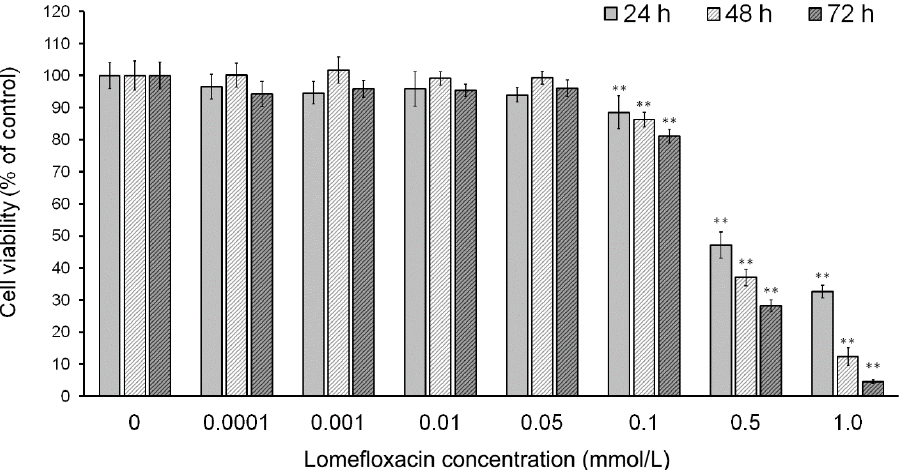
Figure 1. The effect of lomefloxacin on the viability of COLO829 melanoma cells. The cells were treated with various lomefloxacin concentrations (0.0001–1.0 mmol/L) for 24, 48, and 72 h and examined by the WST-1 (4-[3-(4-iodophenyl)-2-(4-nitrophenyl)-2H-5-tetrazolio]-1,3-benzene disulphonate) assay. Data are expressed as percentages of the controls. Mean values ± standard error of the mean (SEM) from three independent experiments ( n = 3) performed in triplicate are presented. ** p < 0.005 versus control samples.